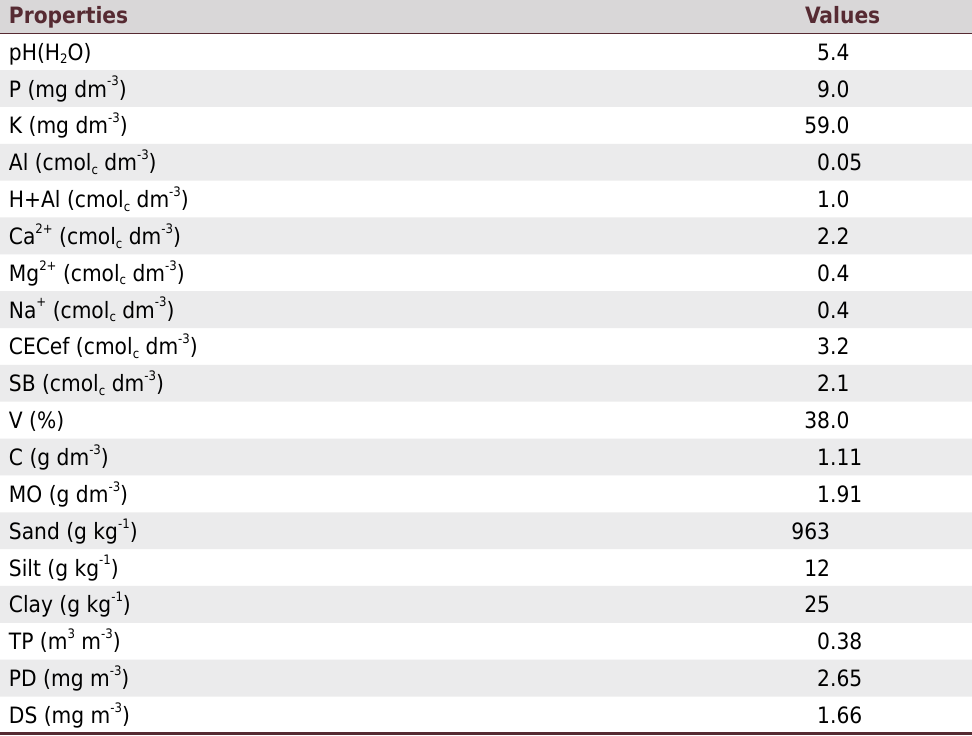
Table 2. Chemical properties from the Gleyic Albic Podzol (Arenic, Drainic, Endic) collected at a soil layer of 0.05-0.40 m, before biochar and K application